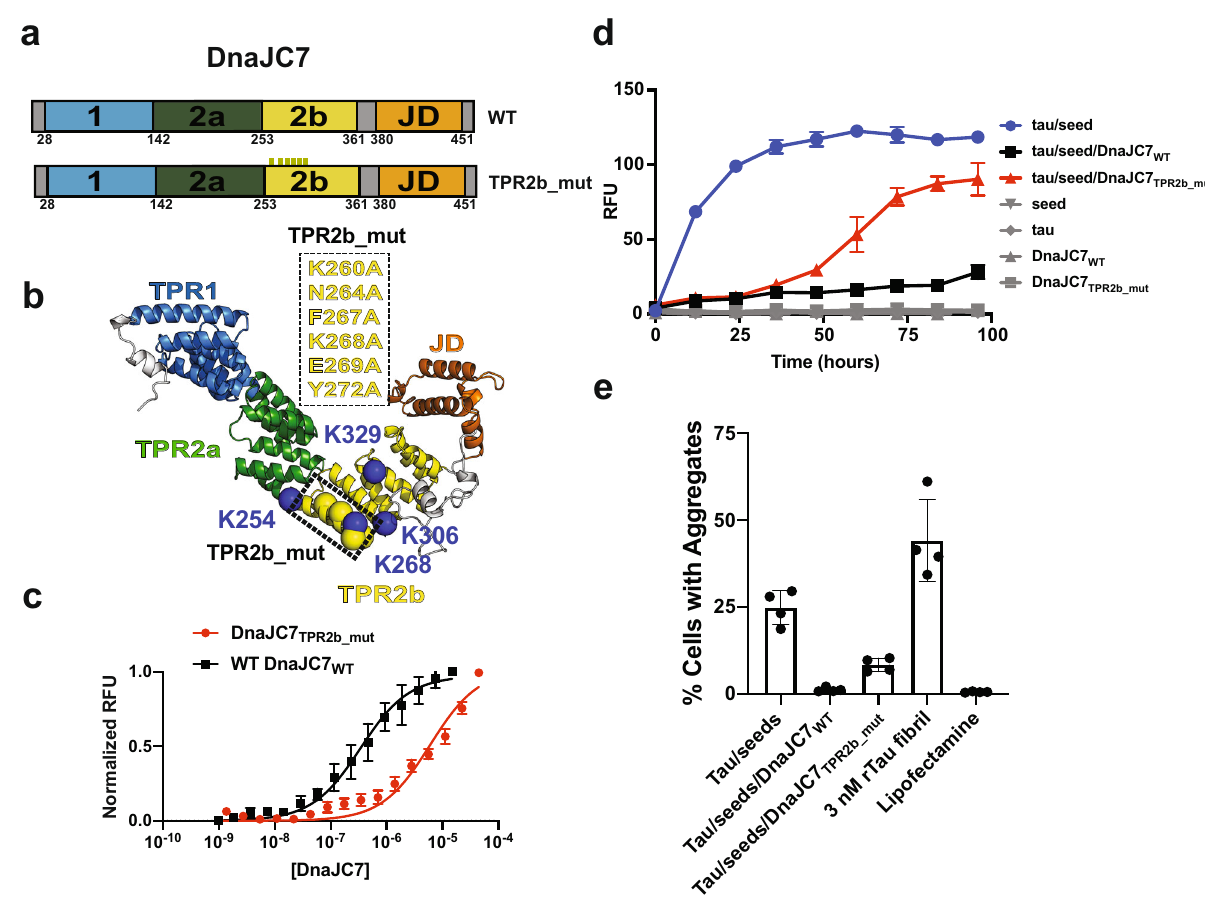
Fig. 6 Mutations in TPR2b of DnaJC7 disrupt tau binding and aggregation-suppression activity. a Schematic diagram of the DnaJC7 TPR2b_mut mutant highlighting the location of the six mutations in TPR2b (K260A, N264A, F267A, K268A, E269A, and Y272A). b Cartoon representation of DnaJC7 TPR2b_mut oriented to highlight the site of the mutation. Sites of the mutation in TPR2b are shown as yellow spheres. The cross-link sites in TPR2b identi fi ed between full-length tau and DnaJC7 are shown as blue spheres (K254, K268, K306 and K329). c MST-binding assay for WT tau:DnaJC7 WT (black) and WT tau:DnaJC7 TPR2b_mut (red). The MST-binding experiments were performed as technical replicates ( n = 3) and each concentration is shown as a mean with standard deviation. The data were fi t to a linear regression model to estimate the binding constant. d 4.4 µ M WT tau aggregation was induced using 50 nM tau monomer seeds (blue) in the presence of equimolar DnaJC7 WT (black) or DnaJC7 TPR2b_mut (red) chaperone. Gray curves show negative controls: tau alone, DnaJC7 WT or DnaJC7 TPR2b_mut alone, and tau monomer seeds alone. Aggregation was monitored using ThT fl uorescence. Experiments were performed as technical replicates ( n = 3) and are shown as mean with standard deviation. e The endpoint and control samples of the in vitro aggregation experiment ( d ) were assayed for seeding activity in tau biosensor cells. The in-cell aggregation assay shows signi fi cant reduction in seeding in the presence of DnaJC7 WT but not in the presence of DnaJC7 TPR2b_mut. Tau seeding experiments were performed as biological replicates ( n = 3) and are shown as mean with standard